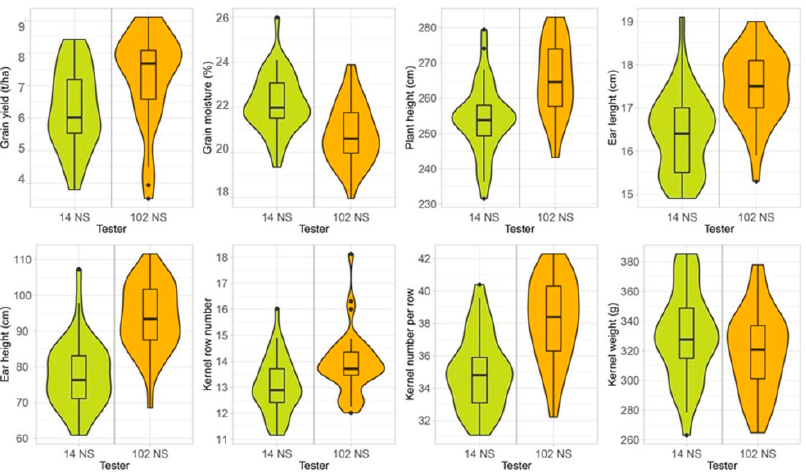
Figure 3. Violin plots of the evaluated quantitative traits.